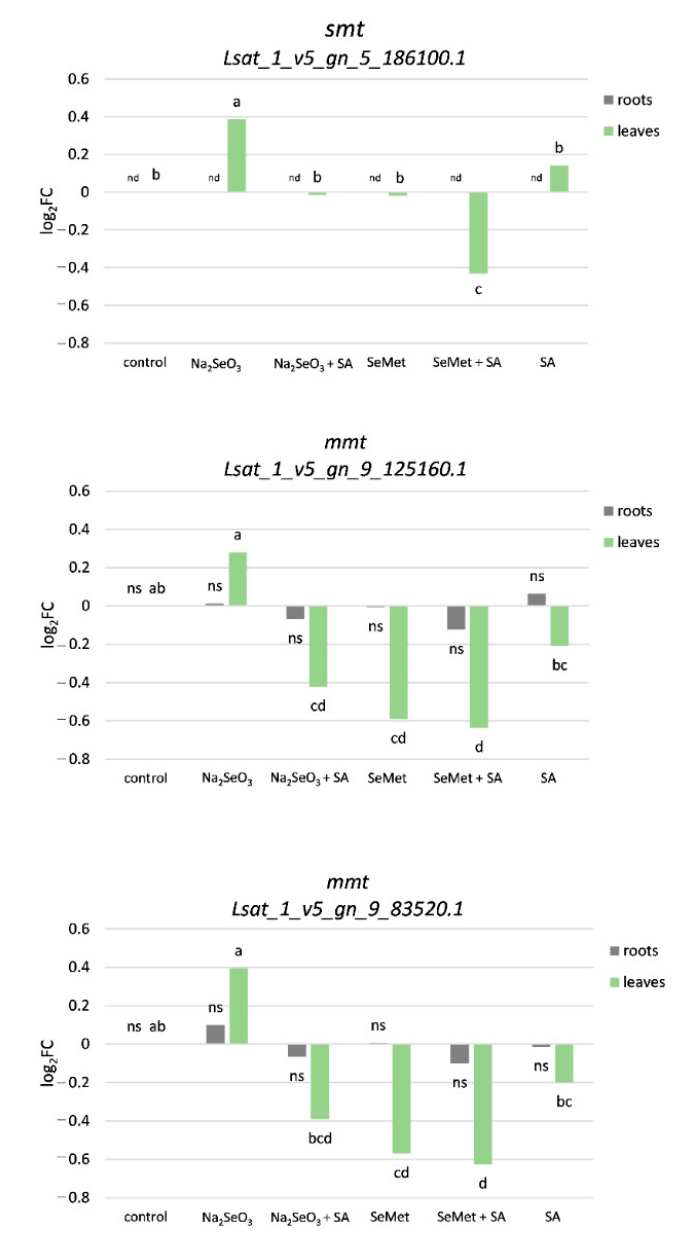
Figure 3. Log 2 fold change in selenocysteine methyltransferase ( smt ) and methionine methyltransferase ( mmt ) gene expression in lettuce roots and leaves. Relative gene expression levels were calculated as a ratio of treatment to control samples from roots and leaves independently. Data are presented as means of four biological samples. Di ff erent letters indicate significant di ff erences between